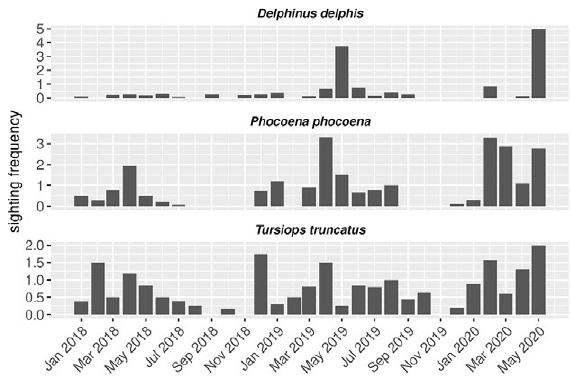
Fig. 4. – Dynamics of sighting frequency for three cetacean species observed in the study area from January 2018 to May 2020.